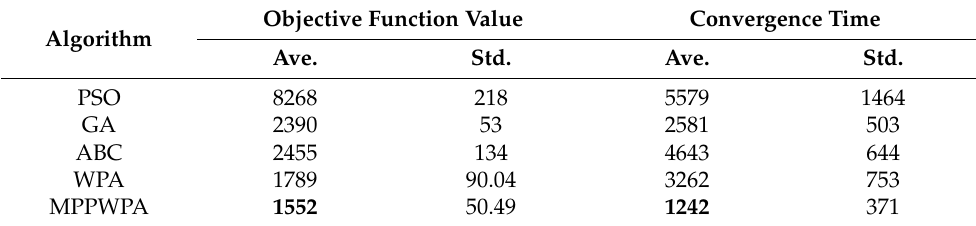
Figure 20. Average objective function values in scenario 3. Table 10. Objective function value and convergence time in scenario 3.